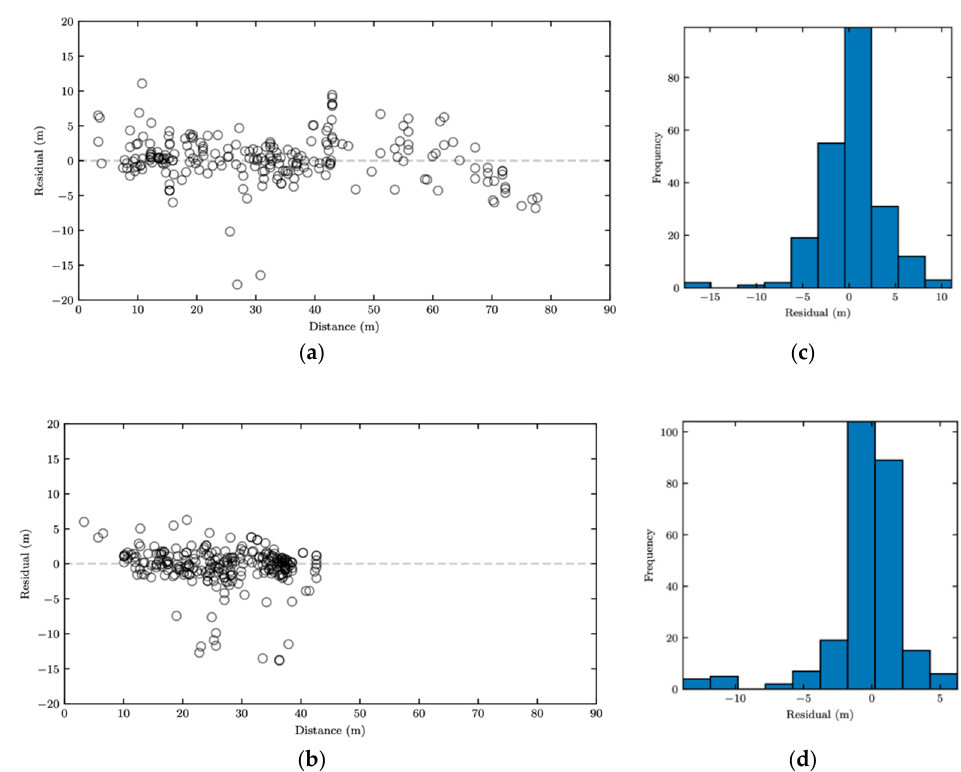
Figure 9 . ANN-based following distance estimation: ( a ) residual pattern of estimated distances for the sedan; ( b ) residual pattern of estimated distances for the pickup truck; ( c ) distribution of residuals of estimated distances for the sedan; and ( d ) distribution of residuals of estimated distances for the pickup truck.